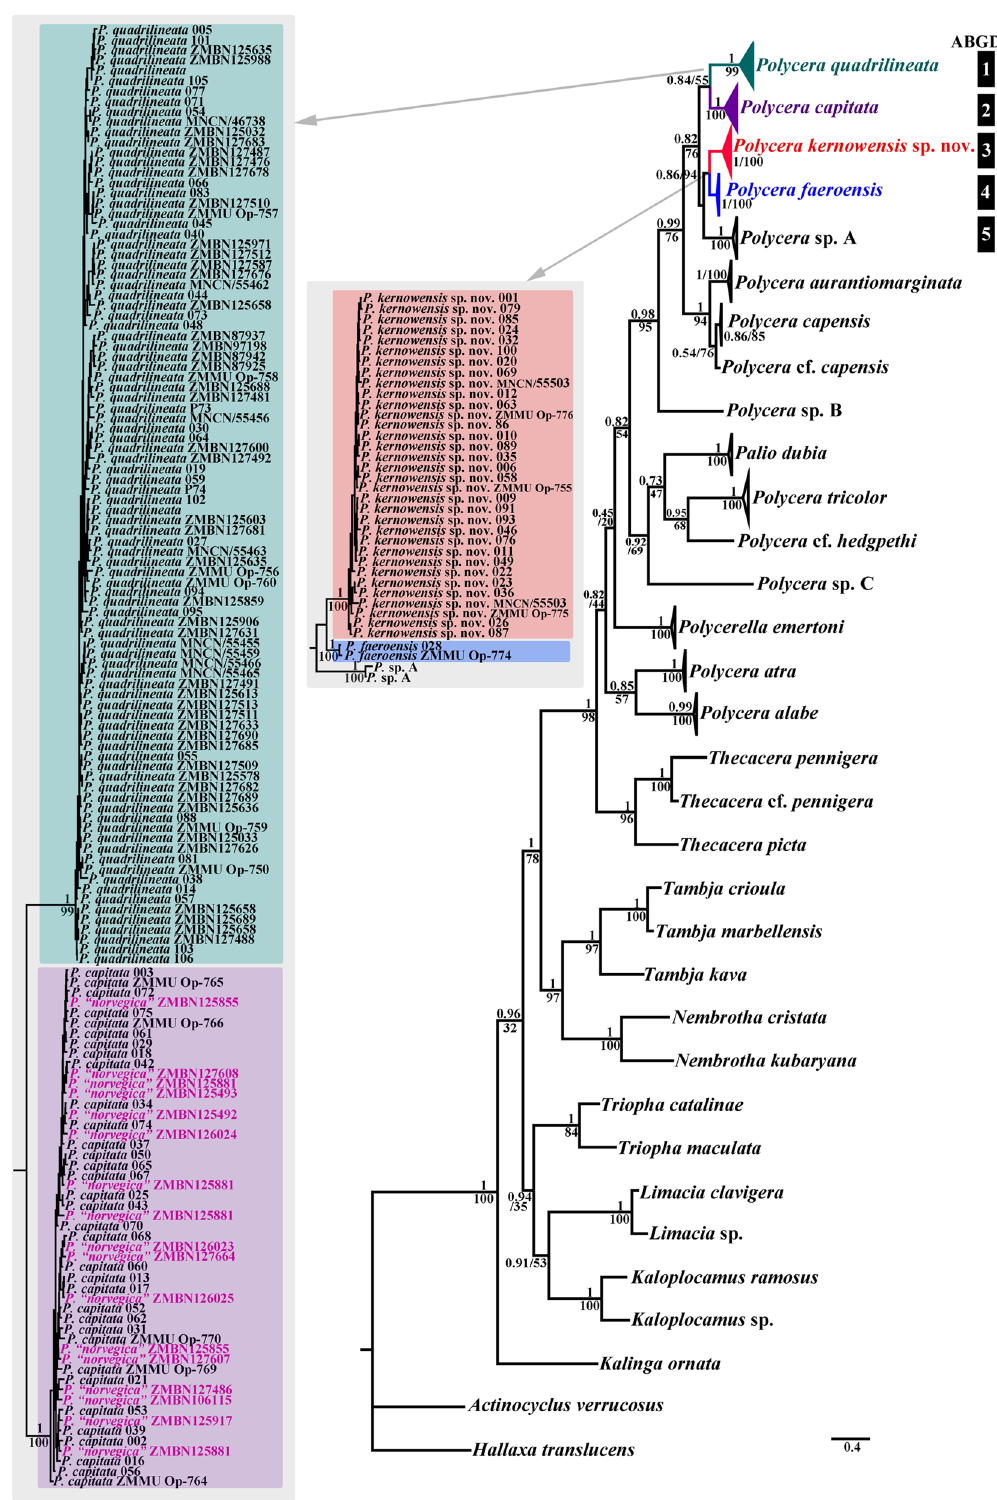
Figure 3. Phylogenetic relationships of Polycera specimen based on COI + 16S concatenated dataset inferred with Bayesian (BI) inference. Numbers above branches represent the posterior probabilities from BI. Numbers below branches indicate the bootstrap values for Maximum Likelihood